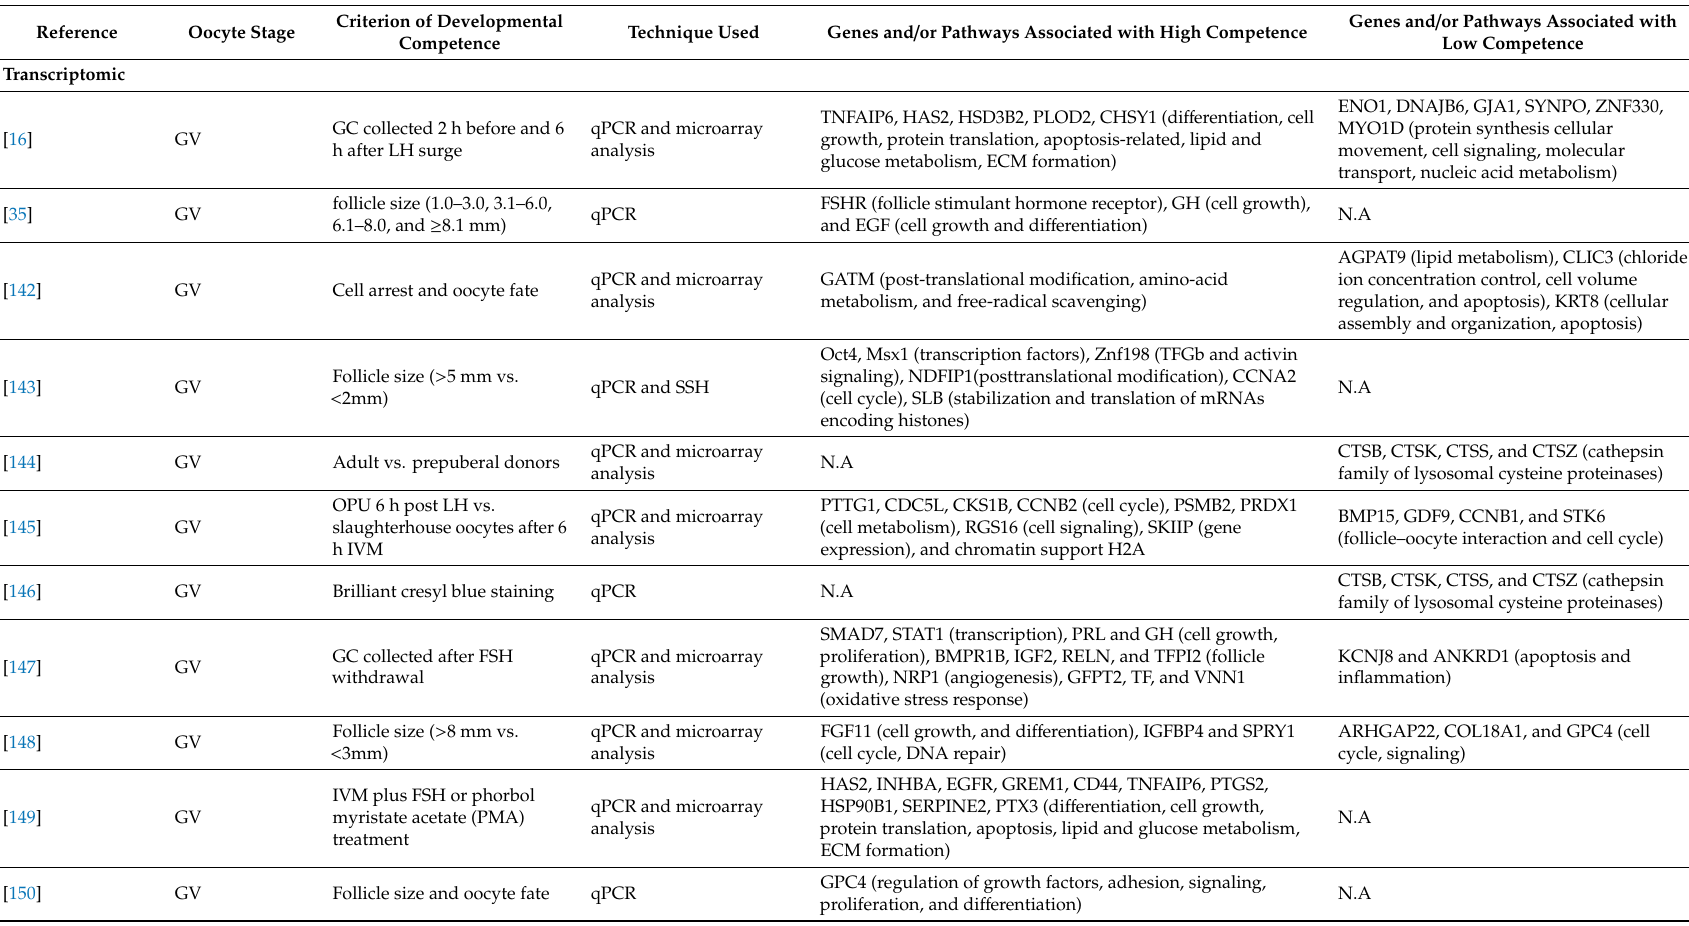
Table 2. Summary of studies performing transcriptomic and proteomic analysis of CC and / or